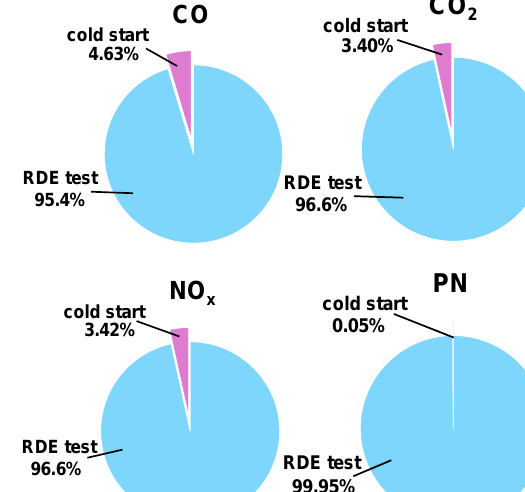
Fig. 12. Share of CO, CO 2 , NO x and PN emissions in urban section during cold start at 8ºC